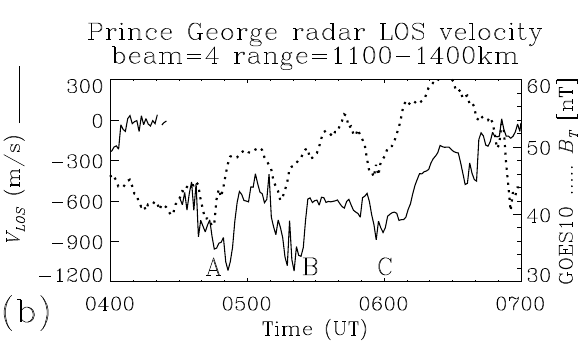
Fig. 5. ( a ) The convection/potential map showing an intense convection pulse B. ( b ) The Prince Fig. 5. (a) The convection/potential map showing an intense con- vection pulse B. (b) The Prince George radar line-of-sight velocity George radar line-of-sight velocity (solid line) and magnetic field magnitude (dotted line) at (solid line) and magnetic field magnitude (dotted line) at geosyn- geosynchronous orbit. chronous